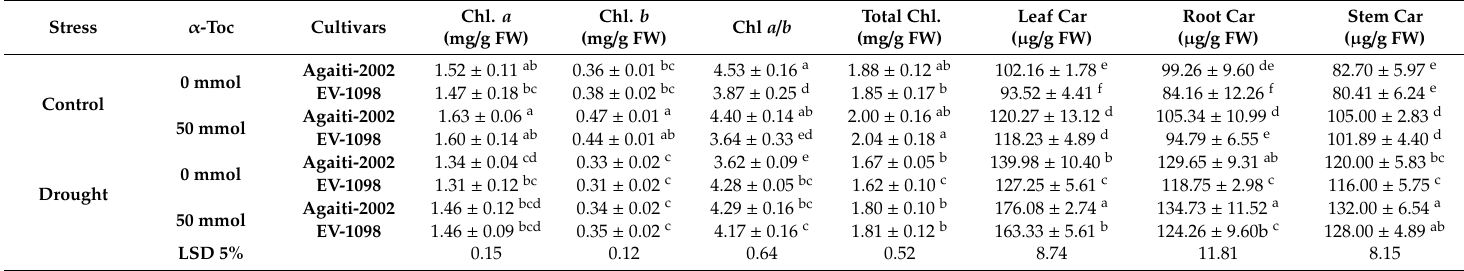
Table 3. Influence of foliar-applied alpha tocopherol on photosynthetic pigments of maize cultivars grown under di ff erent water regimes (mean ± SE; n = 3). Chl. a = leaf chlorophyll a ; Chl. b = leaf chlorophyll b ; Chl a / b = chlorophyll a / b ratio; Total Chl. = total chlorophyll; Leaf Car = leaf carotenoids; Root Car = root carotenoids; Stem Car = stem